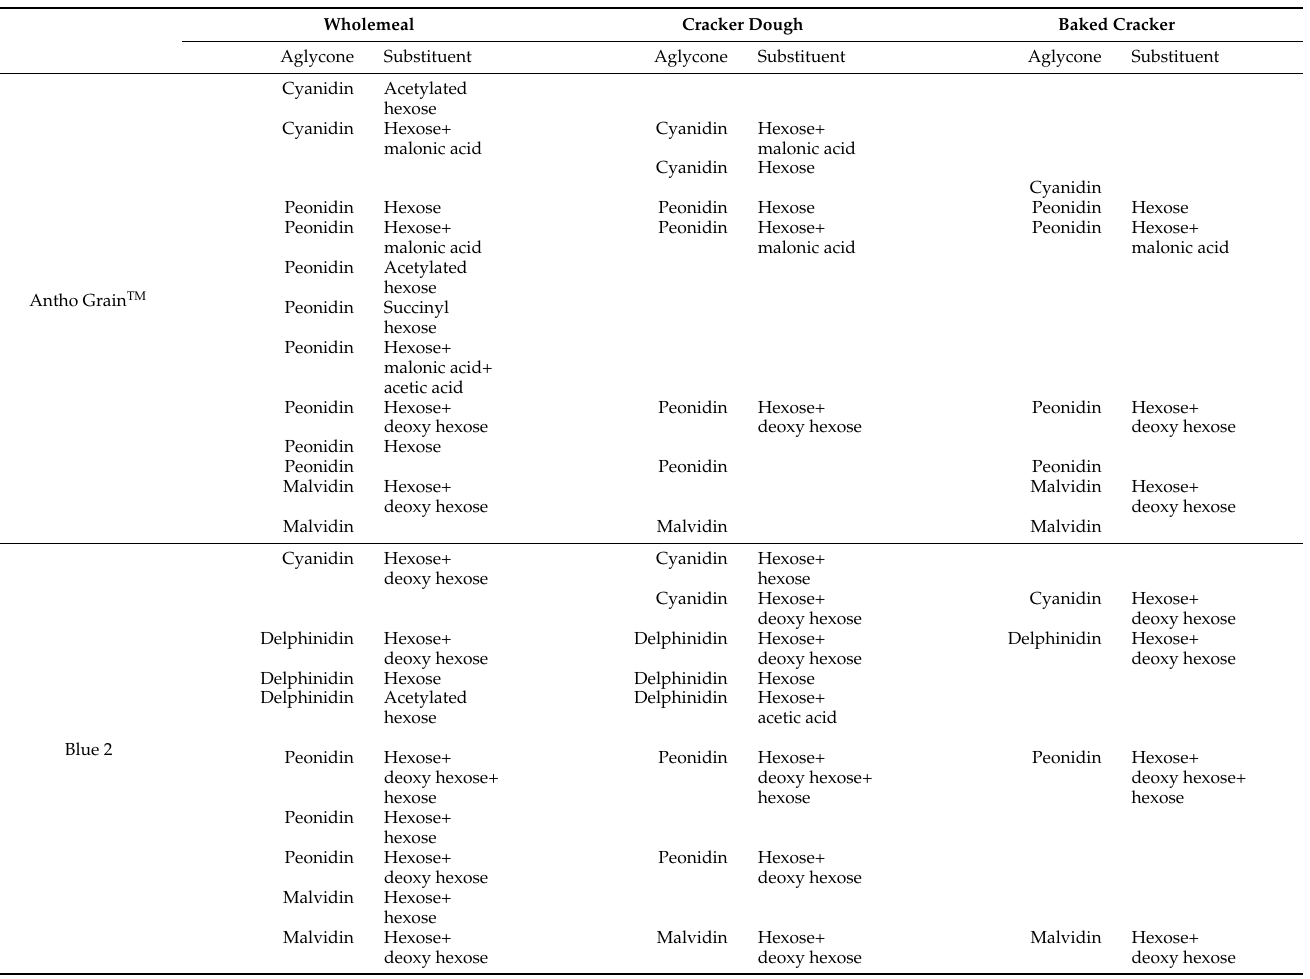
Table 3. Anthocyanin species in AnthoGrain TM and Blue 2 wholemeal, cracker dough, and baked crackers as detected and identified by LC-MS/MS analysis. Wholemeal Cracker Dough Baked